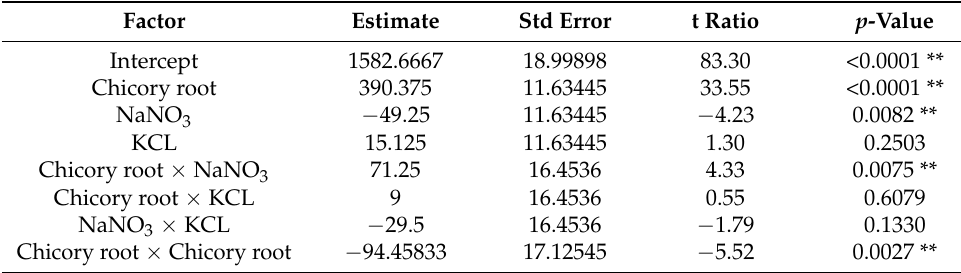
Table 7. Parameter estimates and summary of fit for Box–Behnken